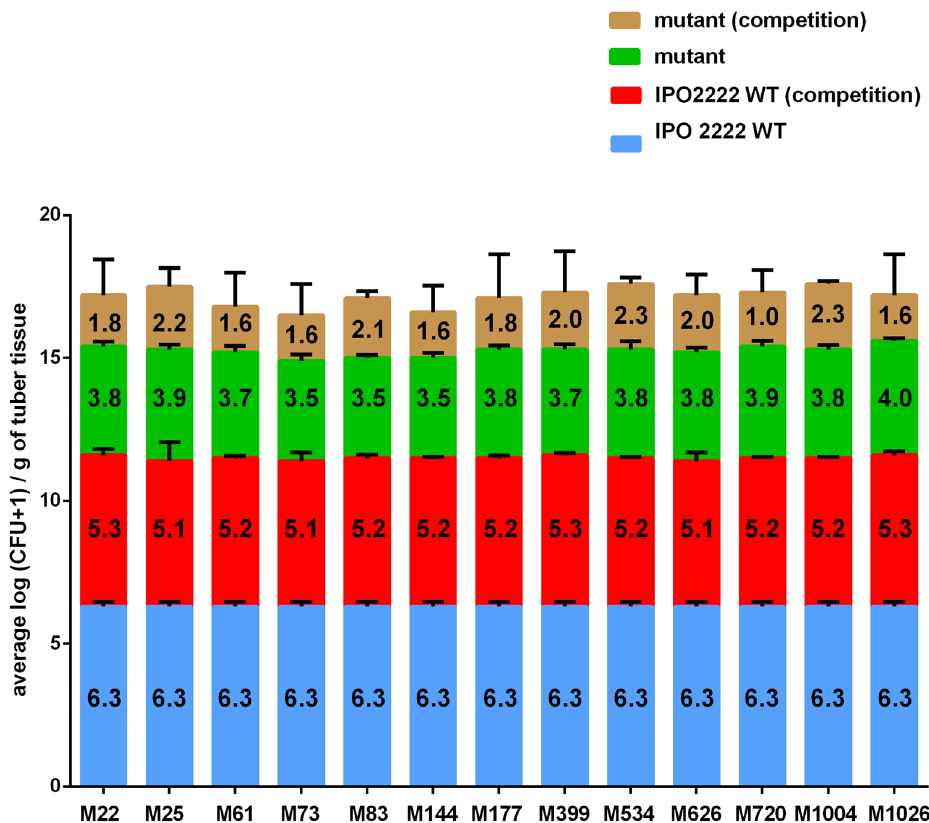
Figure 11. Population size of differentially marked cells of D. solani WT and phage-resistant mutants in potato tubers after co-inoculation or single inoculation into tubers. Potato tubers were inoculated either with fluorescently labelled D. solani IPO 2222 WT, fluorescently labelled individual phage-resistant D. solani Tn5 mutants or co-inoculated with WT strain and individual Tn5 mutant. In the first experiment, a GFP-tagged D. solani IPO 2222 WT and DsRed-tagged phage resistant D. solani mutants were used. In contrast, DsRed- tagged IPO 2222 WT and GFP-tagged phage resistant D. solani mutants were applied in the second experiment. Inoculated tubers were kept under conditions that promote rotting (28º and 80–90% relative humidity). Three days (72 h) post inoculation tubers were sampled and analyzed for the presence of fluorescently tagged bacteria using pour plating. The GFP and DsRed positive colonies were counted. The experiment was replicated one time with the same setup, and the results from both repetitions were averaged for analyses. The numbers inside bars represent the average log (CFU + 1/g of tuber tissue) for the respective treatment. Results were considered to be significant at p = 0.05 and pair-wise differences were obtained using the t-test. Error bars represent standard deviation